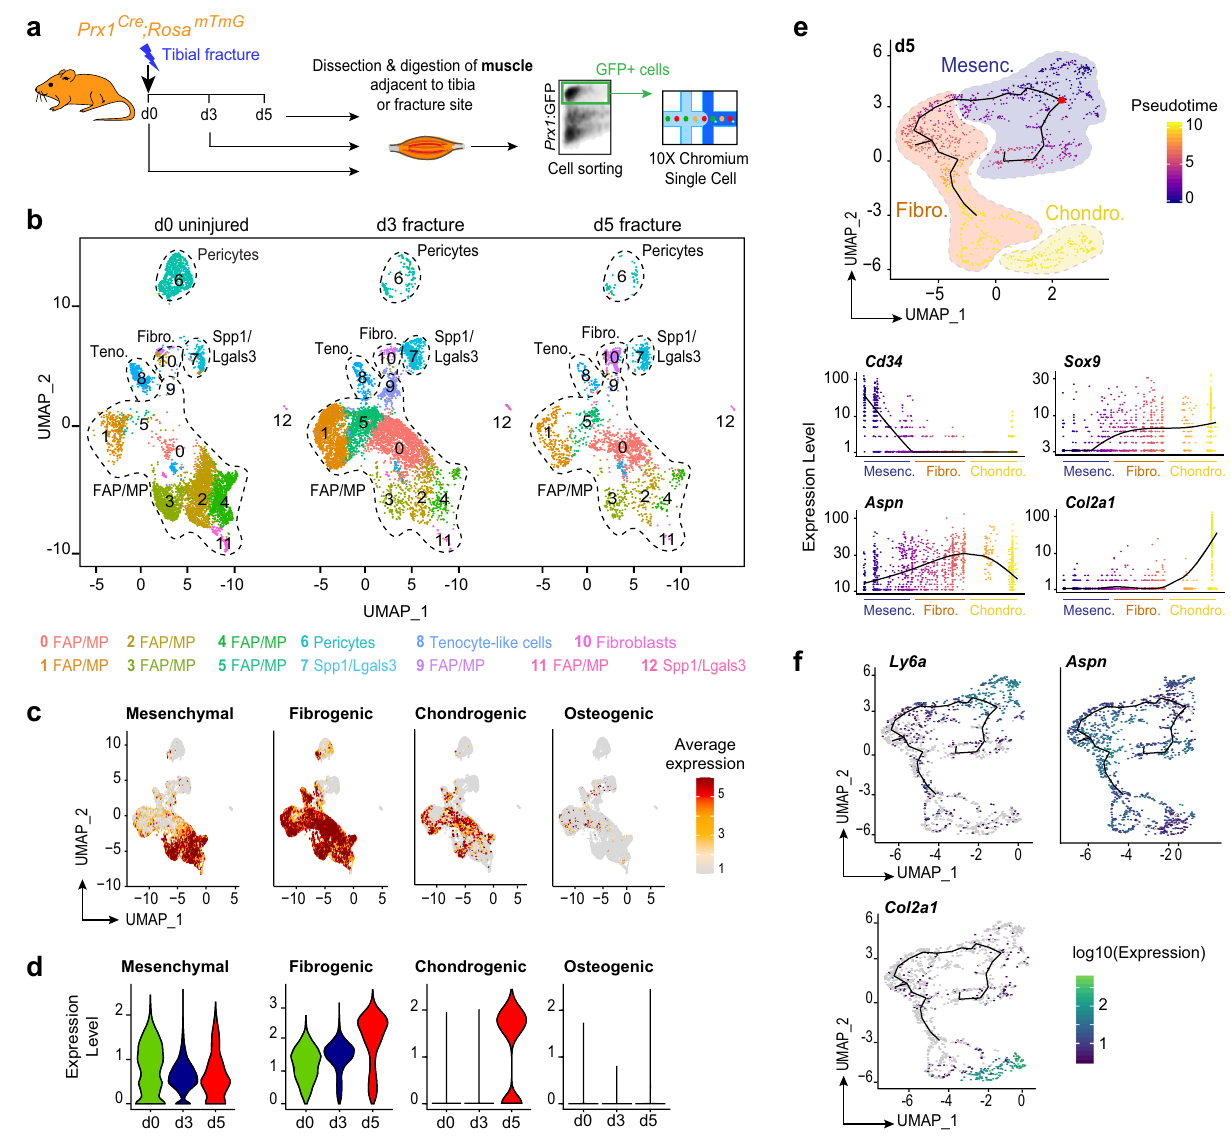
Fig. 3 Single-cell analyses of skeletal muscle mesenchymal progenitors in response to bone fracture. a Experimental design of scRNAseq analyses. Prx1- derived skeletal muscle cells were isolated from skeletal muscles surrounding the tibia at day 0, day 3, and day 5 post non-stabilized fracture and sorted based on GFP-expression prior to scRNAseq. b UMAP projection of color-coded clustering of integrated d0, d3, and d5 samples. Sub-populations are limited by a black dotted line and cluster identities are indicated below. Teno. tenocyte like cells, Fibro. fi broblasts. c FeaturePlot of mesenchymal, fi brogenic, chondrogenic and osteogenic lineages scores. d Expression of mesenchymal, fi brogenic, chondrogenic, and osteogenic lineages scores per sample. e Pseudotime analysis of FAP/MP at d5 post-fracture (top). Expression of Cd34 , Aspn, Sox9, and Col2a1 genes along pseudotime (bottom). Fibro. fi brogenic, Mesenc. mesenchymal, Chondro. chondrogenic. f FeaturePlot of Ly6a , Aspn, and Col2a1 expression as markers of mesenchymal, fi brogenic, and chondrogenic lineages, respectively, in d5 post-fracture